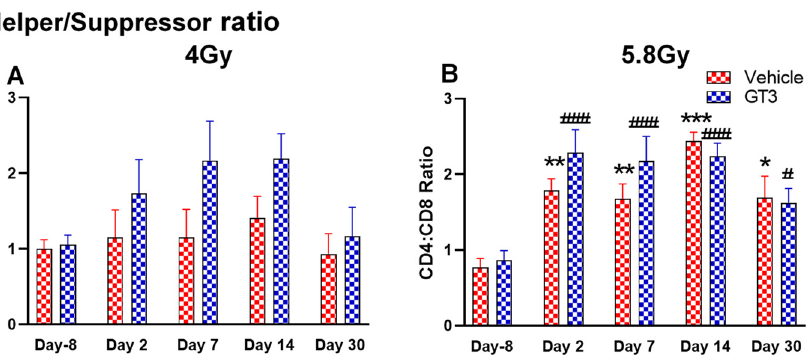
Figure 8. Effects of 4 Gy ( A ) and 5.8 Gy ( B ) on CD4:CD8 ratio in BM of NHPs. NHPs received GT3 (37.5 mg/kg) or vehicle 24 h prior to irradiation (4 and 5.8 Gy). BM was collected at various time points and the expression of the CD4:CD8 ratio was analyzed. Data are expressed as mean ± SEM. * p < 0.05, ** p < 0.01, *** p < 0.001 vs. vehicle day-8; # p < 0.05, ### p < 0.001 vs. GT3 day-8.